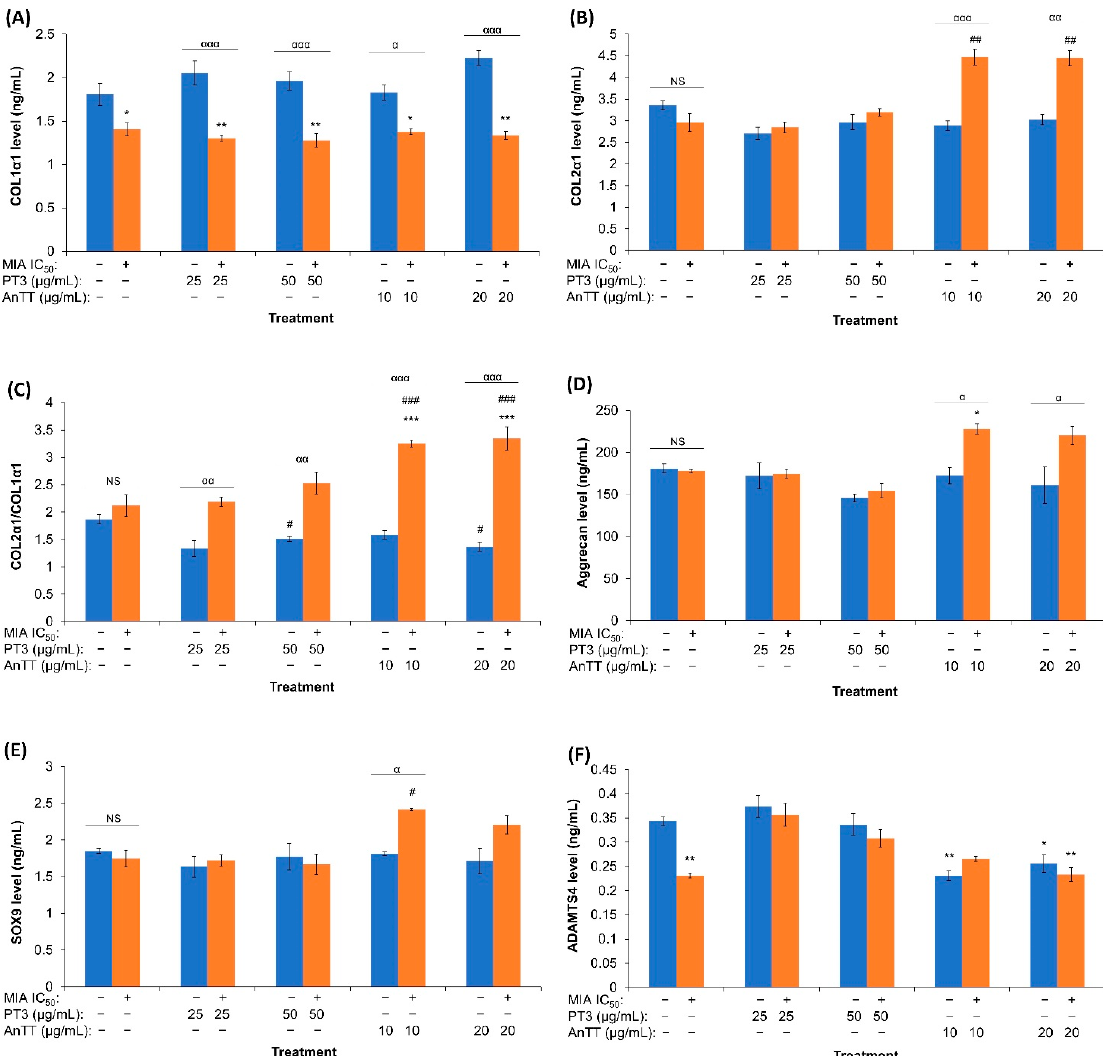
Figure 5. The protein expression of COL1 α 1 ( A ), COL2 α 1 ( B ), COL2 α 1/COL1 α 1 ( C ), aggrecan ( D ), SOX9 ( E ) and ADAMTS4 ( F ) in SW1353 chondrocytes treated for 24 h with AnTT or PT3 alone, and in combination with MIA (IC 50 31.5 µM). All results were from at least 3 independent experiments. Two technical replicates were used during measurement, according to manufacturer’s instruction. The data were displayed in mean ± SEM. *, ** and *** indicate a significant difference of p < 0.05, p < 0.01 and p < 0.001 compared to VC; # , ## and ### indicate a significant difference of p < 0.05, p < 0.01 and p < 0.001 compared to MIA control; α , αα and ααα indicate a significant difference of p < 0.05, p < 0.01 and p < 0.001 between group with and without MIA treatment. NS indicates no significant difference between groups.